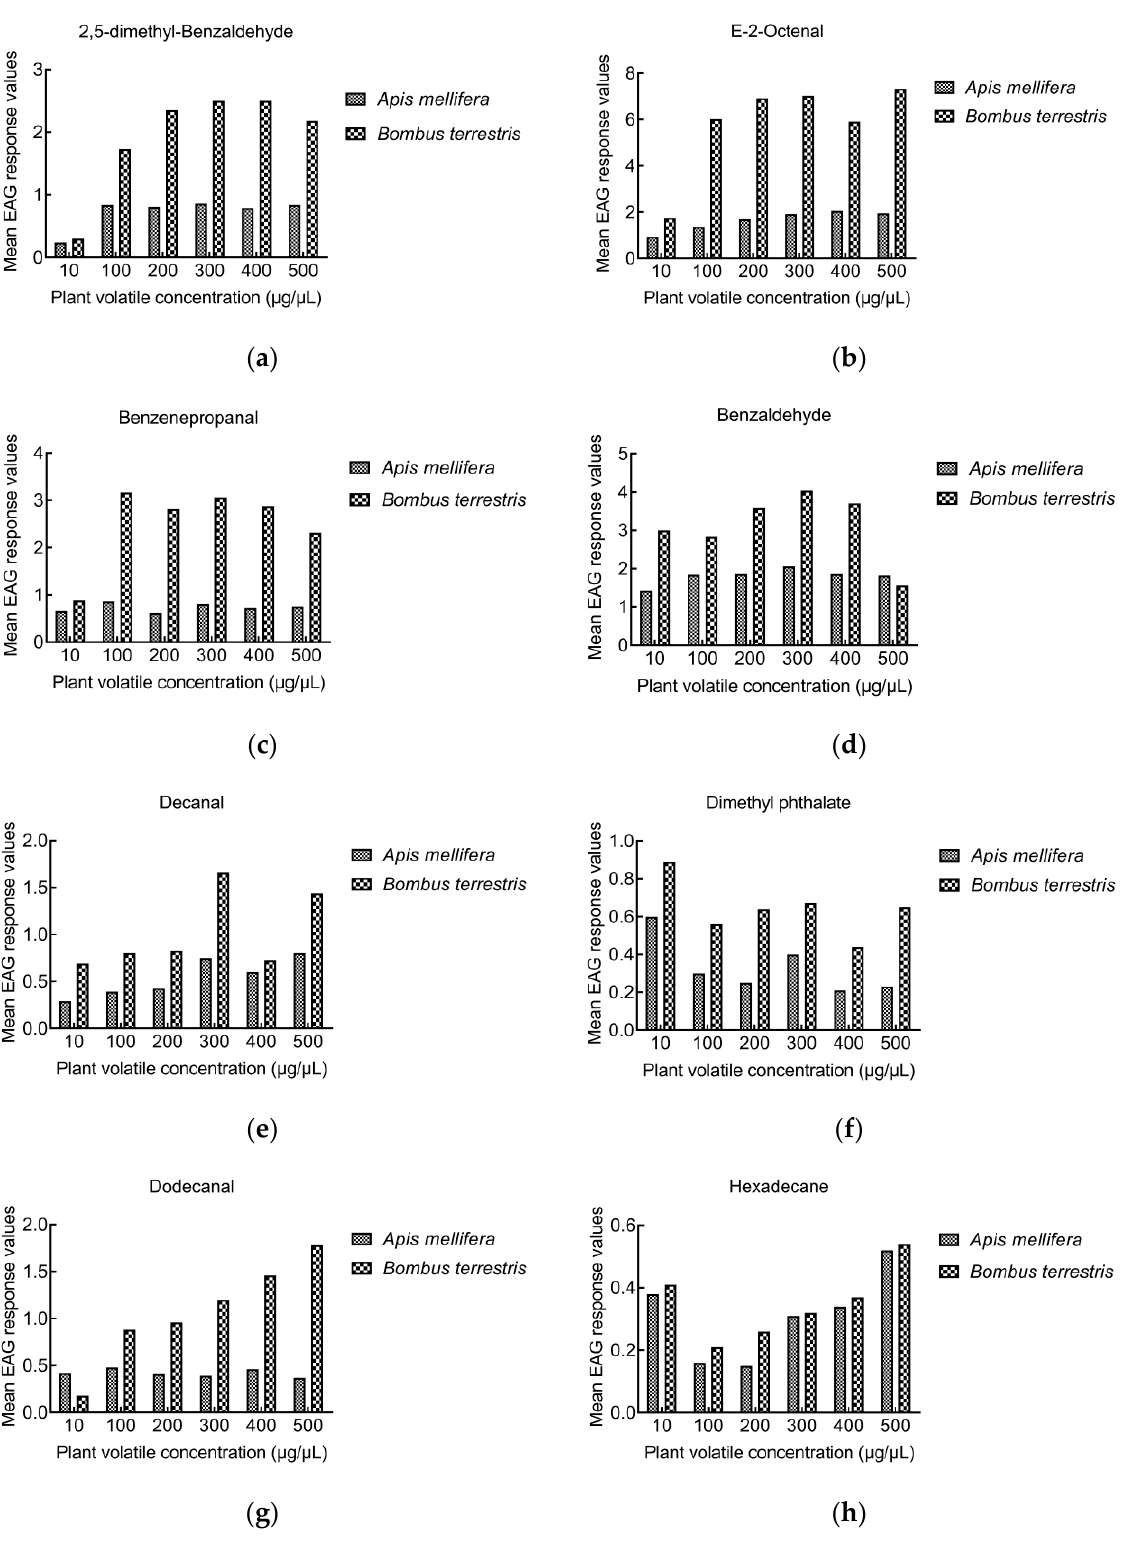
Figure 2. Comparison of EAG responses between A. mellifera and B. terrestris . The rEAGs of B. terrestris higher than those of A. mellifera : ( a ) 2,5-dimethyl-benzaldehyde, ( b ) e-2-octenal, ( c ) benzenepropanal, ( d ) benzaldehyde, ( e ) decanal, ( f ) dimethyl phthalate, ( g ) dodecanal, ( h )